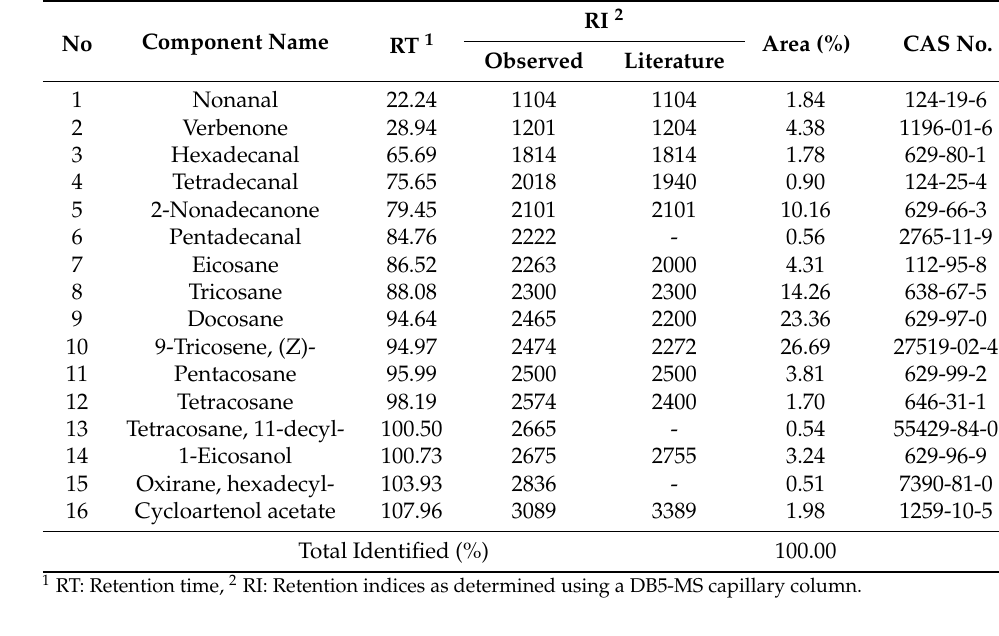
Table 1. Chemical composition of Salix koreensis Anderss flower absolute.